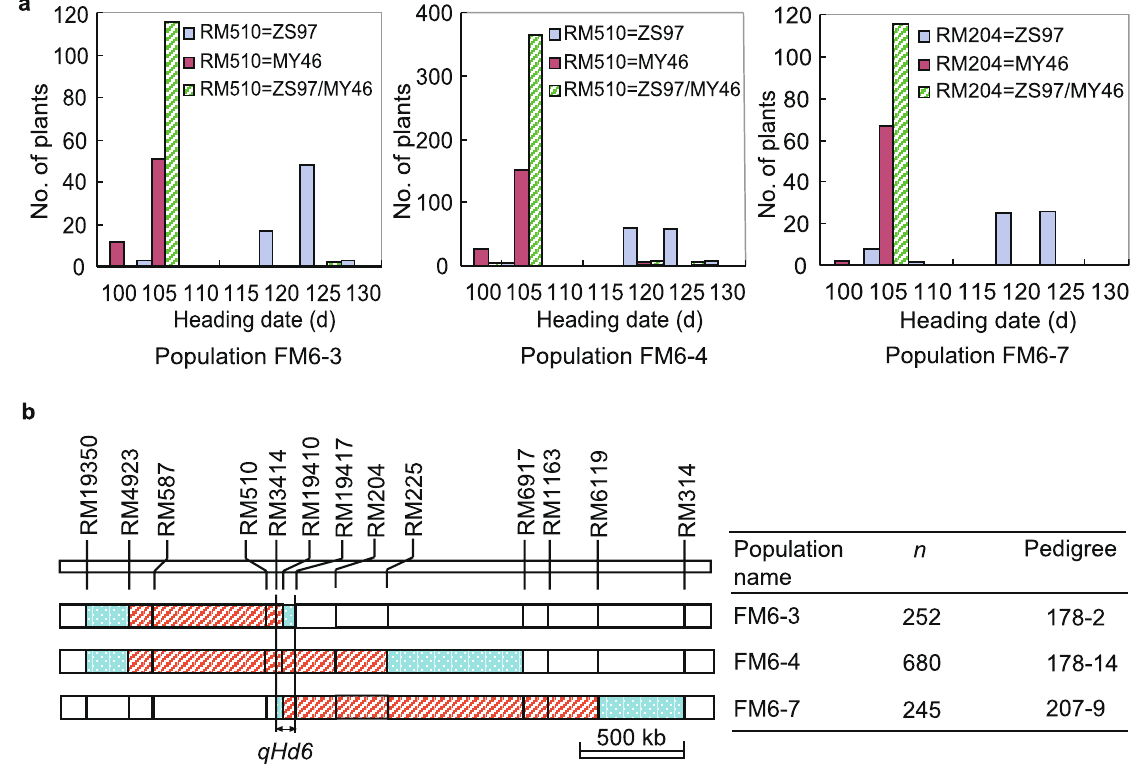
Figure 2. Heading date segregation of the three NIL-F 2 populations firstly used in this study. ( a ) Distribution of heading date and its association with the three genotypic groups in each population. ( b ) Segregating regions of the three populations and the 96.4-kb region mapped for qHd6 . The three populations are each constructed from selfed seeds of an RH plant in F 9 which is a progeny of an F 7 plant of the indica rice cross ZS97/MY46. Pedigree refers to the pedigree of the residual heterozygote that was selfed to produce the NIL-F 2 population, in which the first and second numbers are the Plant No. in F 8 and F 9 , respectively. n , number of plants.